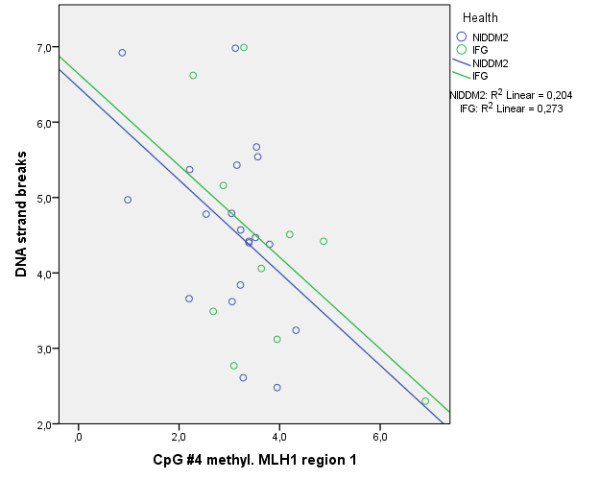
Correlation between DNA strandbreaks and CpG number4 methylation. Significant correlation over all time points between the occurrence of DNA strand breaks and the DNA methylation level at CpG number 4 within the MLH1 region 1 (P < 0.01; r = −0.486).